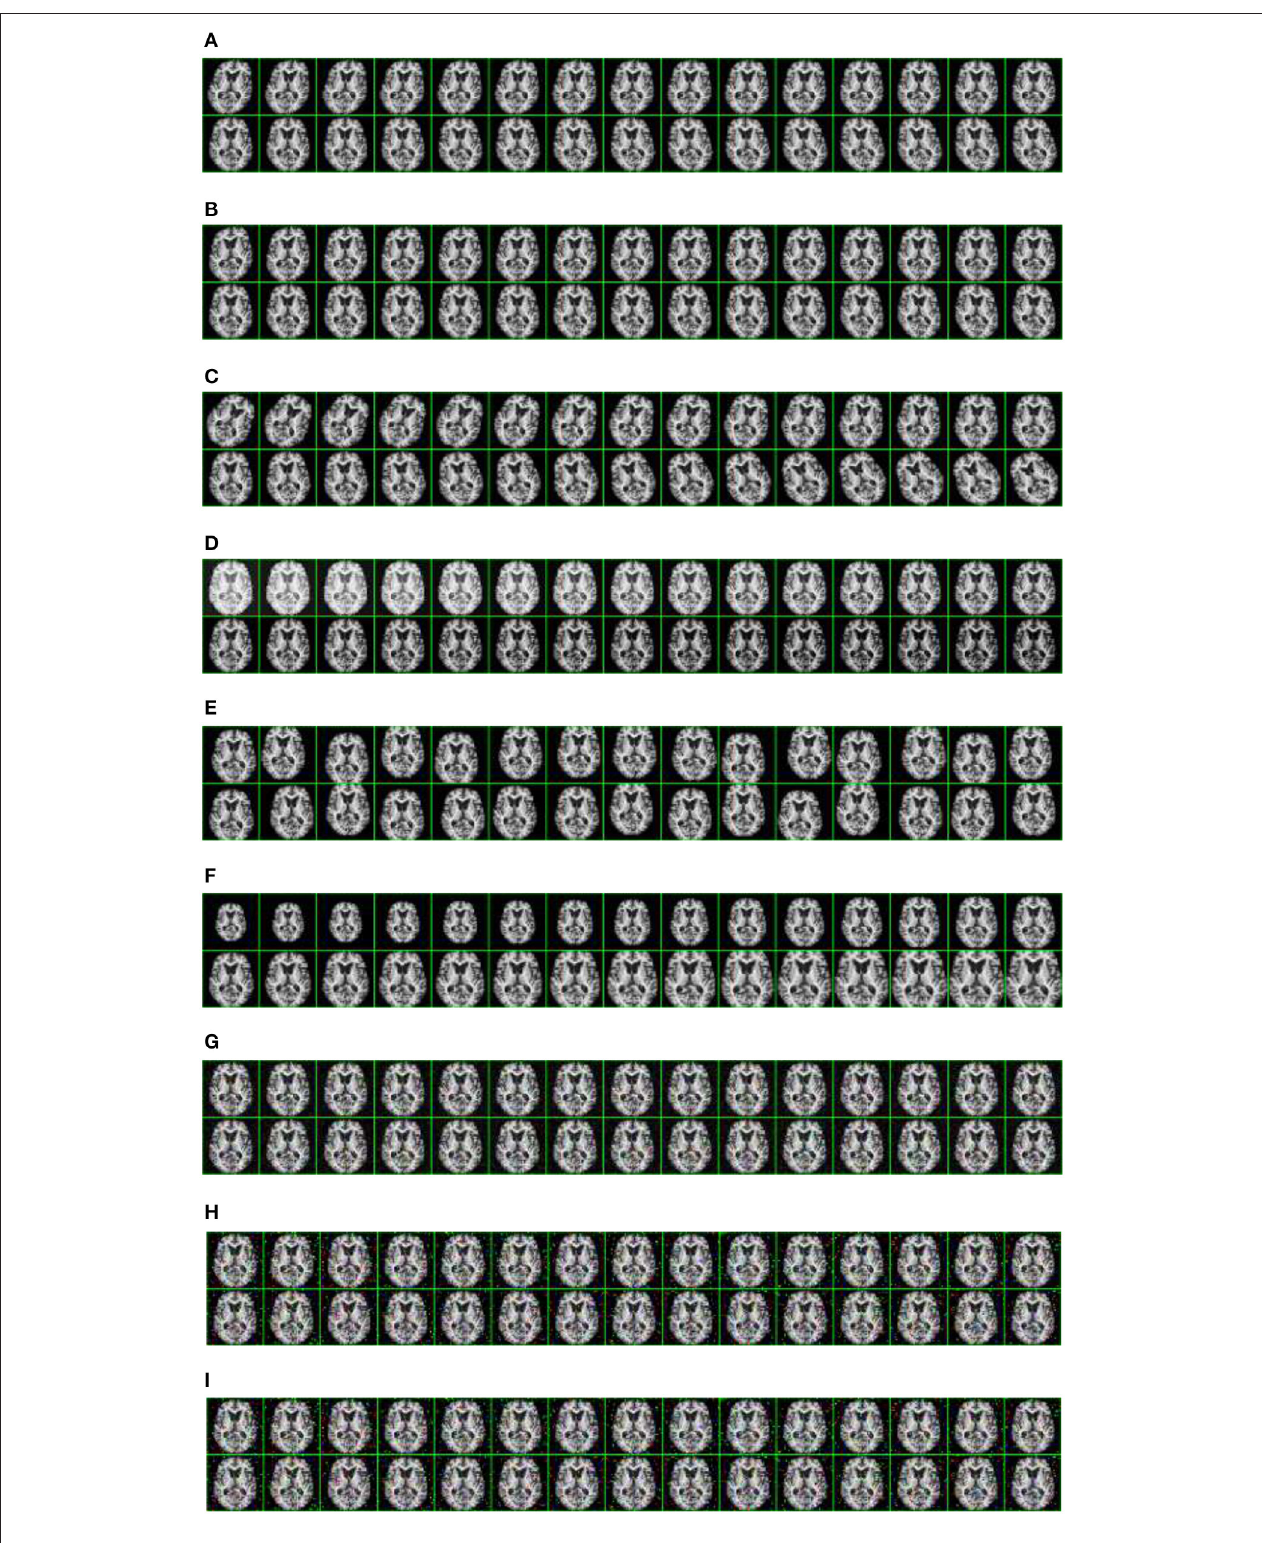
FIGURE 12 | Results of data augmentation. (A) Horizontal shear, (B) Vertical shear, (C) Image rotation, (D) Gamma correction, (E) Random translation, (F) Scaling, (G) Gaussian noise, (H) Salt-and-pepper noise, (I) Speckle noise.